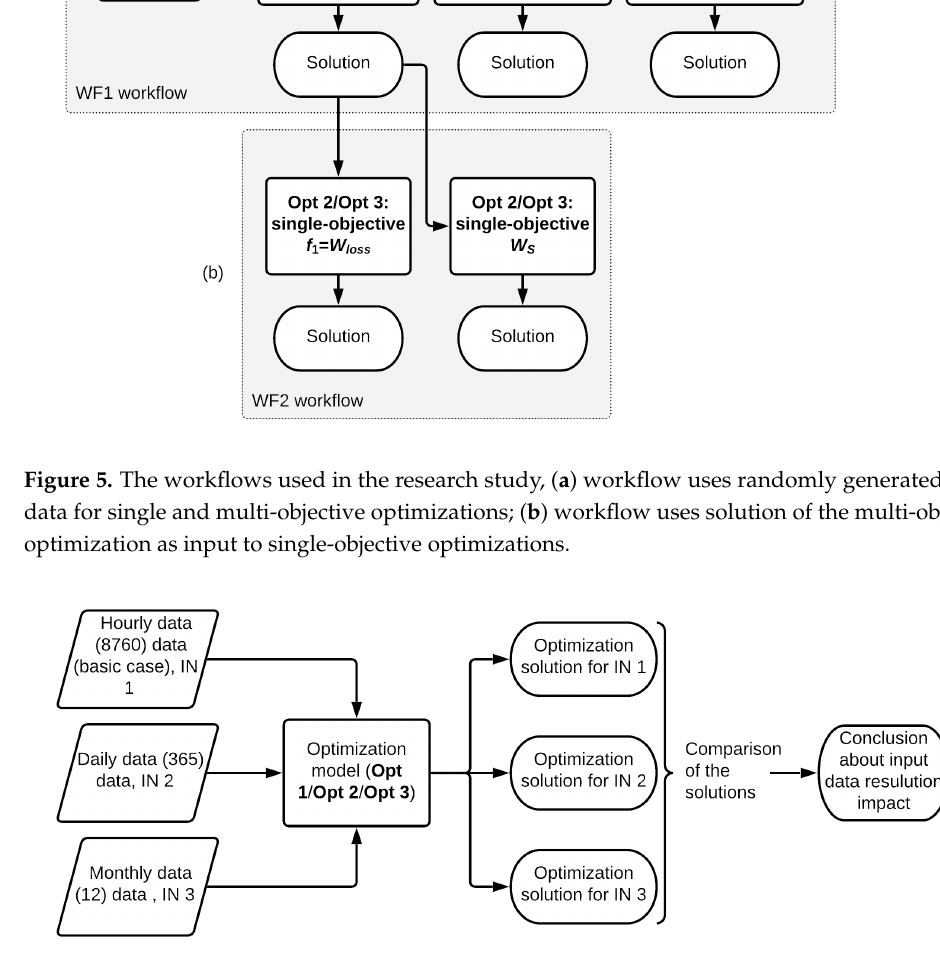
Figure 6. Application of input data with different resolutions in the proposed